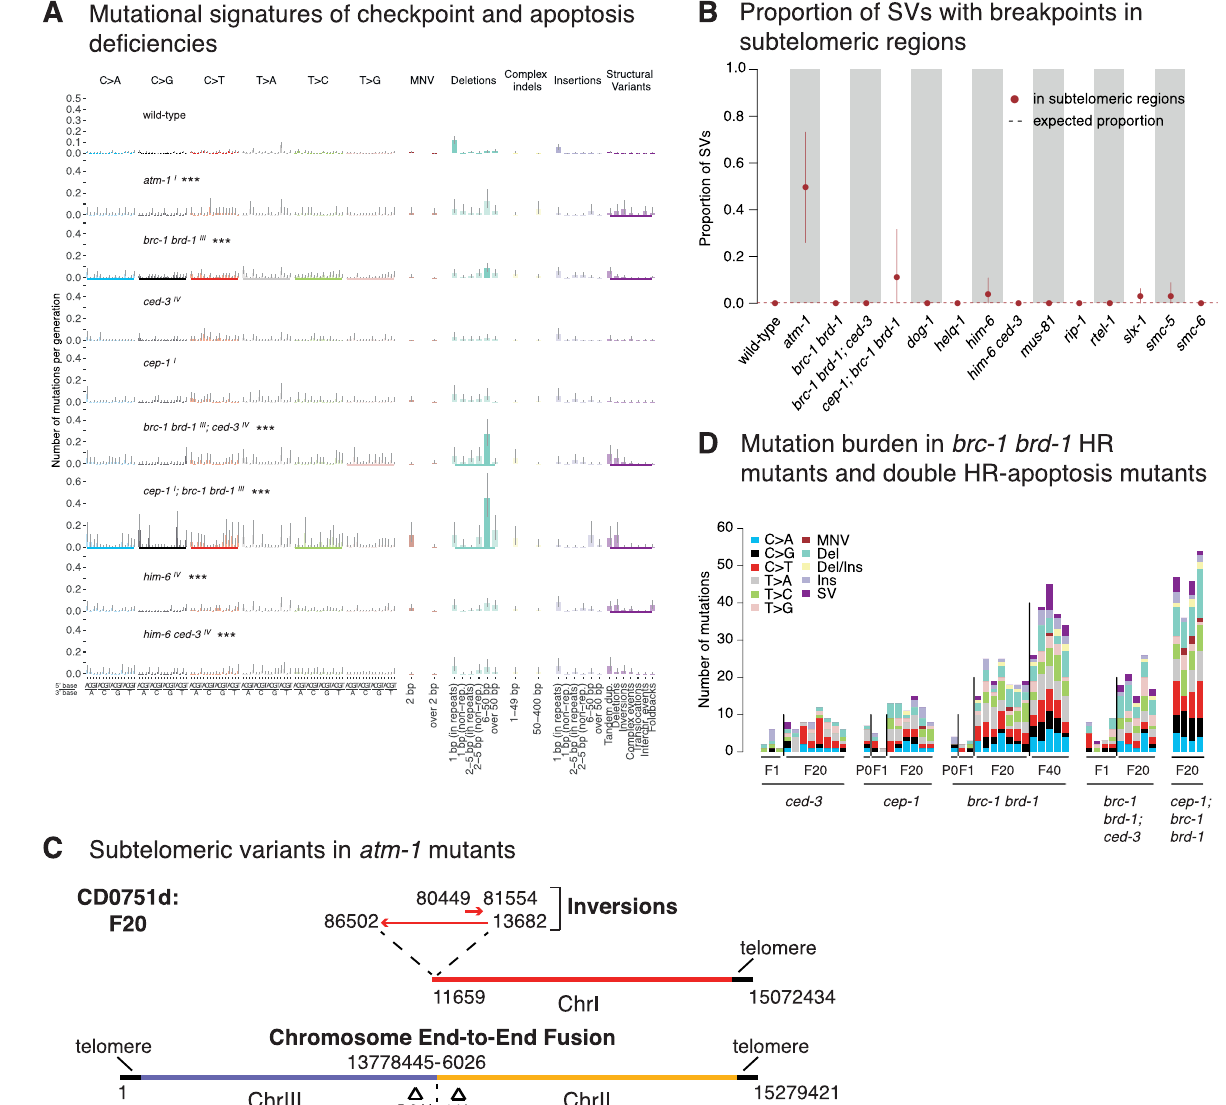
Fig 6. Signatures and genomic features of mutations in DNA damage checkpoint and apoptosis deficient C . elegans . A. Mutational signatures of mutants that exhibited statistically significant differences to wild-type mutation rates. The chromosomes on which respective genes are located are indicated in superscript following each mutant name. Layout as Fig 4A. B. Proportion of SVs with breakpoints into subtelomeric regions across wild- type and mutants that exhibit elevated SV rates. Dotted lines represent the fraction of variants expected to occur in subtelomeric regions by chance. C . Examples of subtelomeric structural variants in atm-1 mutants. D. Quantification of mutation burden in indicated DNA repair mutants for initial generations and F20 and F40 generations as shown. Information related to the 528 whole genome sequencing WGS primary-source datasets (56 deposited in this study, 472 deposited in (Suppl Data 1 and Supple Note 1 of [10] can be found in S1 Table).